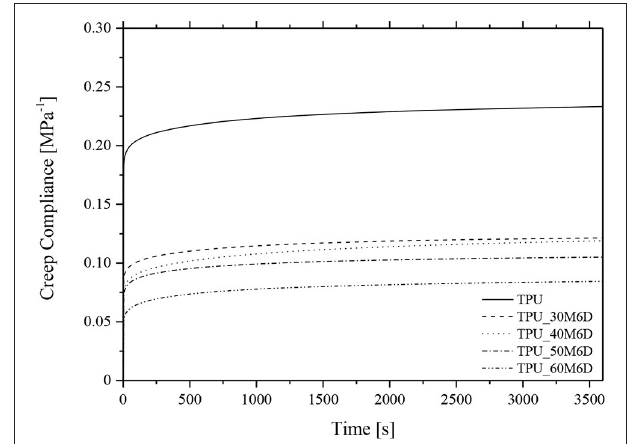
FIGURE 7 | Creep compliance curves at 30 ◦ C of neat TPU and relative